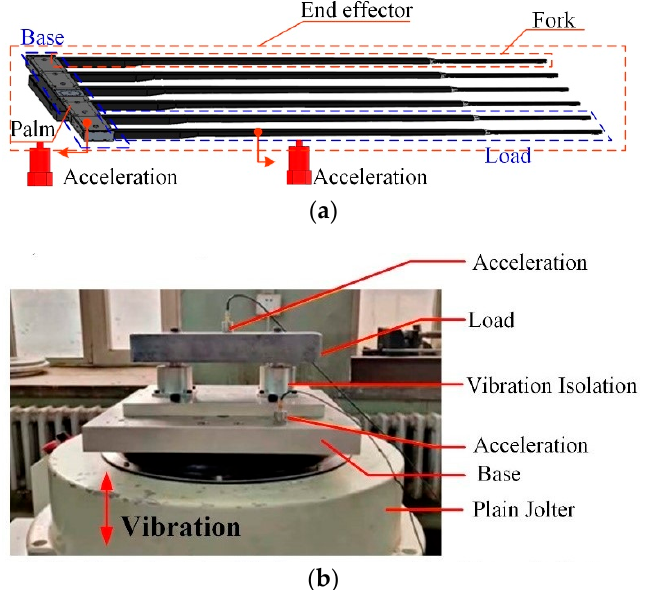
Figure 10. The dynamic frequency sweeping system of the plain jolter.